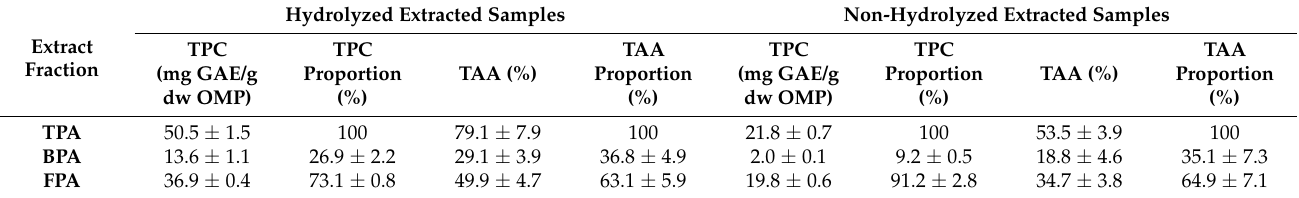
Table 5. Total phenolic content and their proportion of different factions of olive mill pomace extracted full-fat samples and extracted defatted